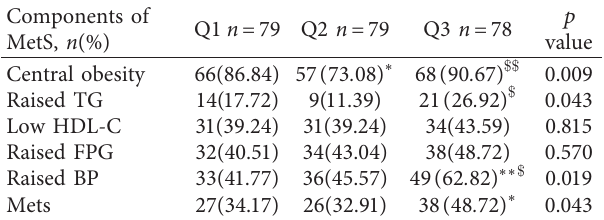
Table 4: FSH is positively associated with risks of MetS biomarkers.